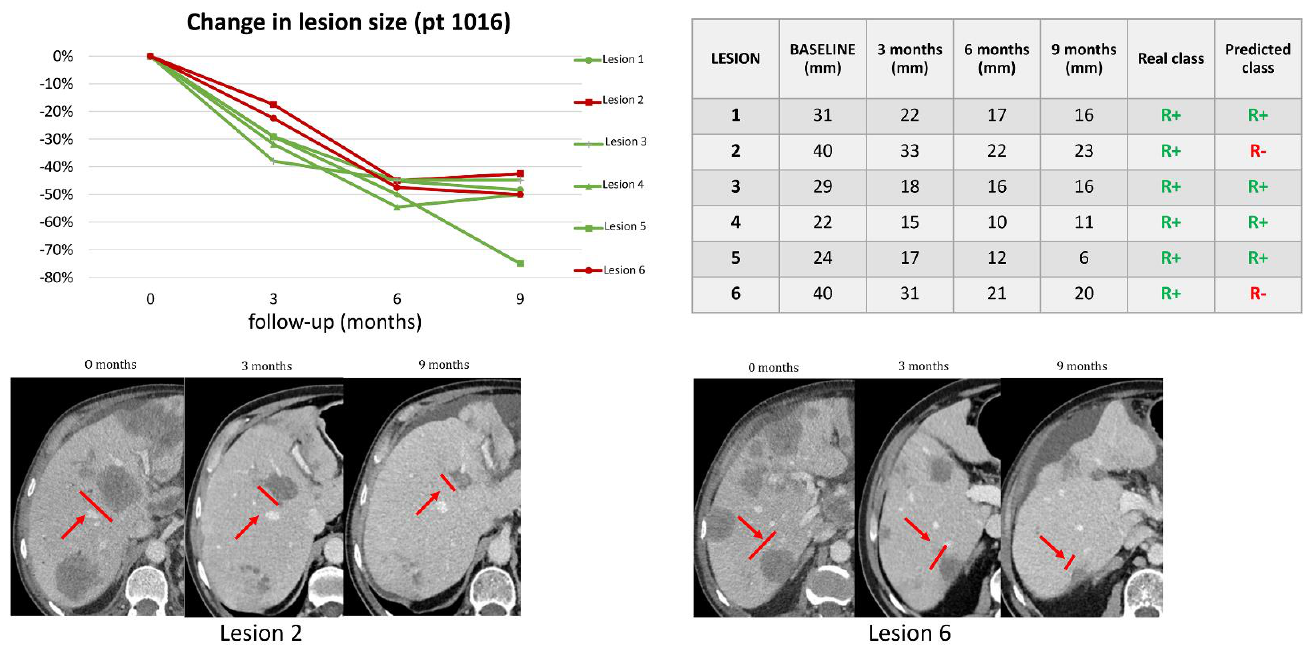
Figure 4. In patient 1016, our algorithm correctly classified a R+ 4/6 lesions while 2/6 lesions were misclassified as R − . The red line in the graph represents the metastasis that went into progression before 8 months, while the green lines represent metastases that responded for at least 8 months The table lists the patient’s liver metastases, size at baseline, and subsequent timepoints. The real and predicted class columns show respectively the 8-month response of each lesion based on size variations and the classification as predicted by the classifiers.